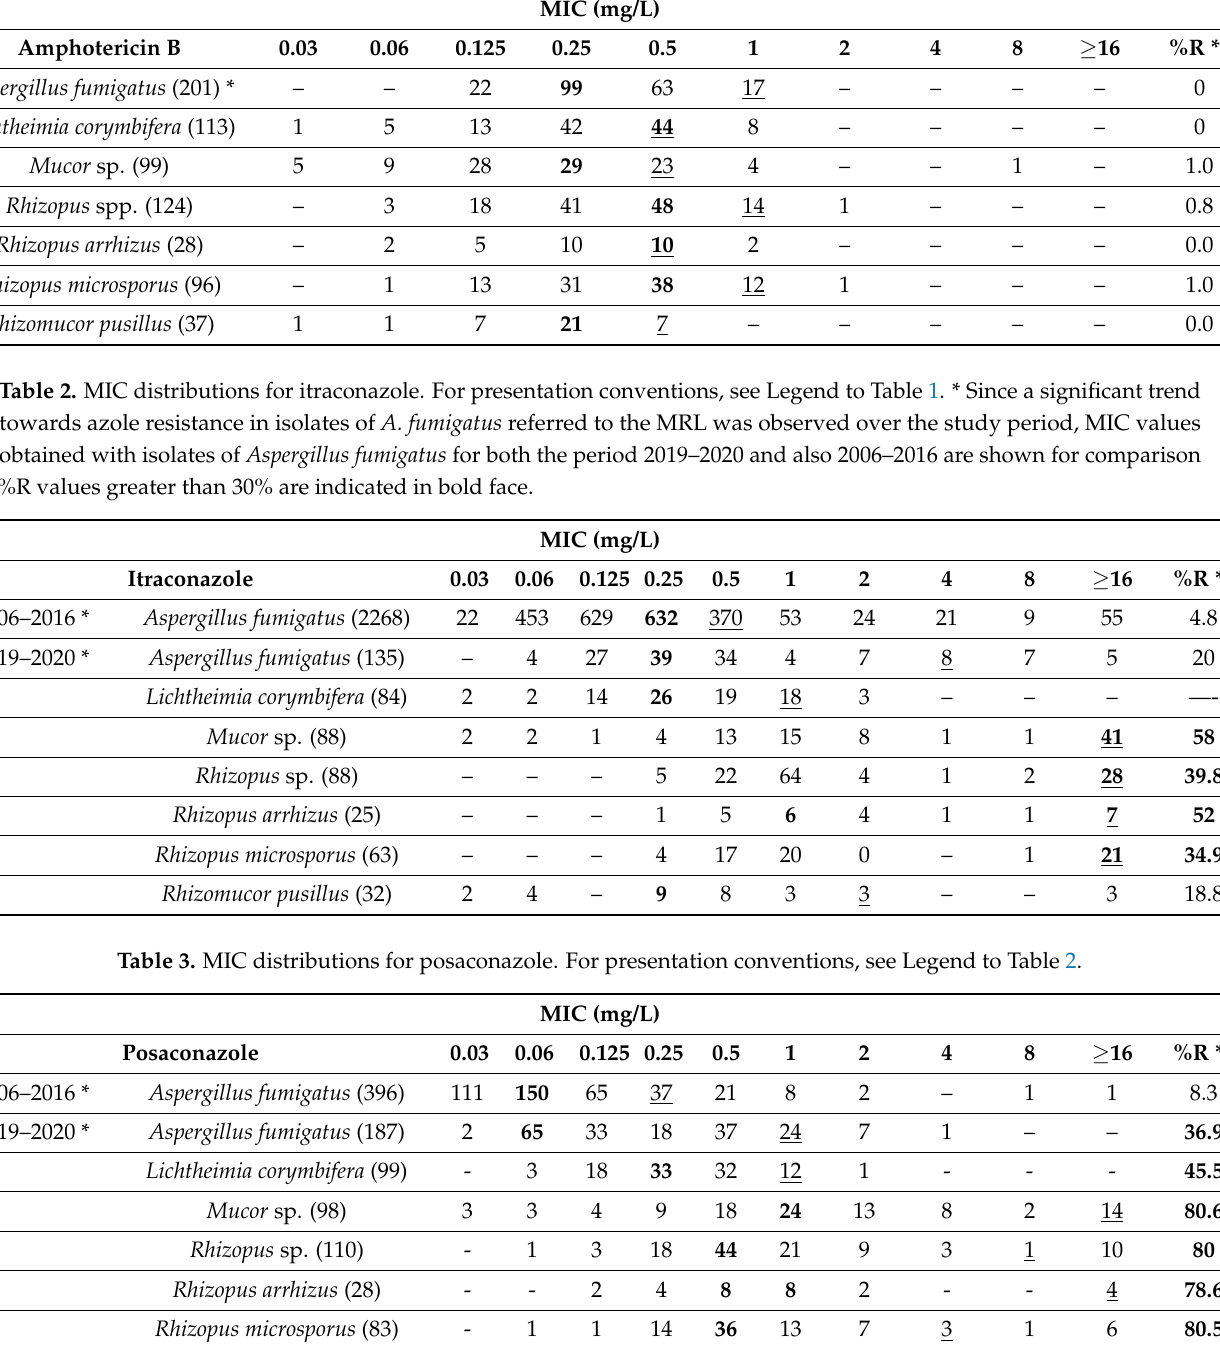
Table 1. Minimum inhibitory concentration (MIC) distributions for amphotericin B and key members of the Mucorales. The number of isolates is given in parentheses, together with the number of isolates with each given MIC value.* MIC values obtained with isolates of Aspergillus fumigatus for the period 2019–2020 are shown for comparison. ** %R denotes the proportion of isolates with non-wild-type MICs (i.e., MICs greater than the CLSI ECV or clinical breakpoint proposed for A. fumigatus , dashed line [24]). Modal MICs are indicated in bold, MIC 90 values are underlined. MIC (mg/L)